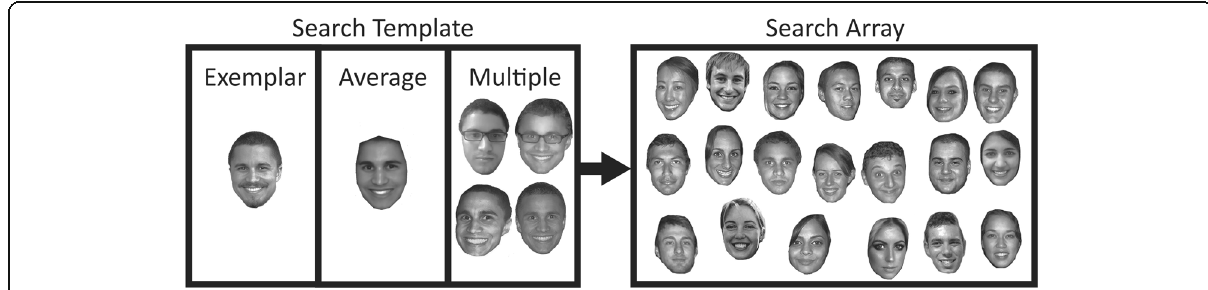
Fig. 1 Example showing the same target face with the search templates and search arrays used in all experiments. On each trial one of three search templates ( left ) was shown on screen before the search array ( right ). Participants had to find the target in the array by clicking on the faces in the image, which in the example is located in the second row, third from the left. In Experiment 1, we compare search performance when participants were presented with a single exemplar image vs an average image. In Experiment 2, we compare performance in single vs multiple exemplar conditions and in Experiment 3 we compare average vs multiple images. Images are representative of the materials used in tasks, but for copyright restrictions, we are not able to provide the actual materials used in our